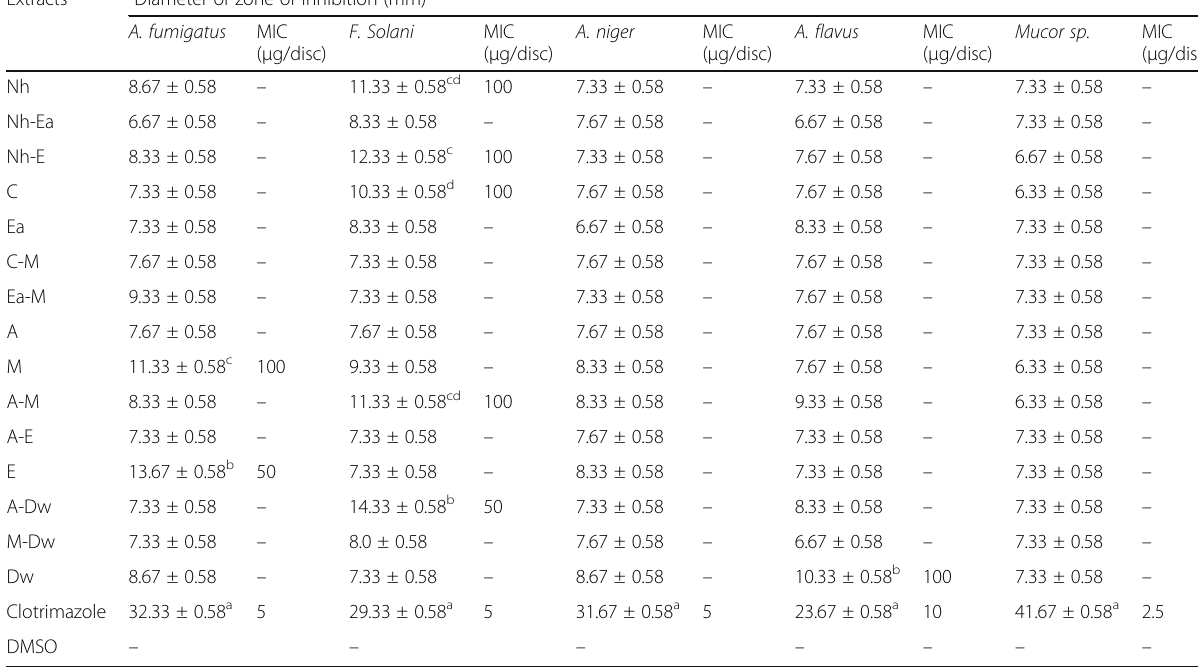
Table 4 Antifungal activity of A. bracteosa extracts Extracts * Diameter of zone of inhibition (mm)